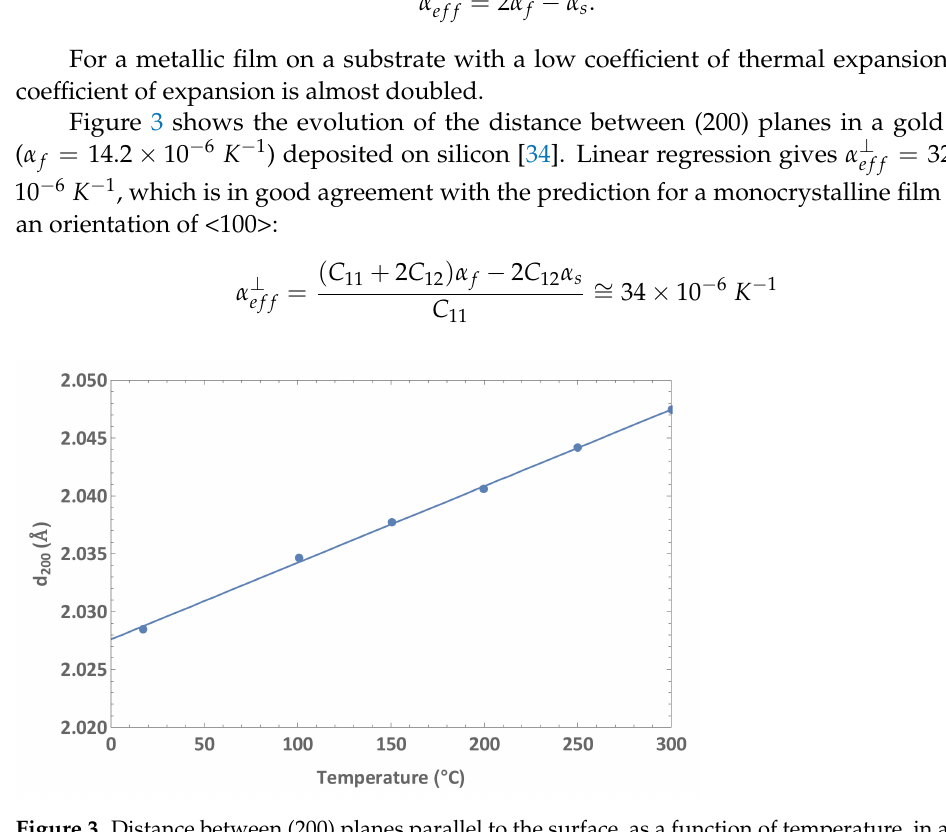
Figure 3. Distance between (200) planes parallel to the surface, as a function of temperature, in a gold film deposited on silicon. The Poisson effect gives rise to an effective coefficient of thermal expansion that is more than twice the coefficient of free